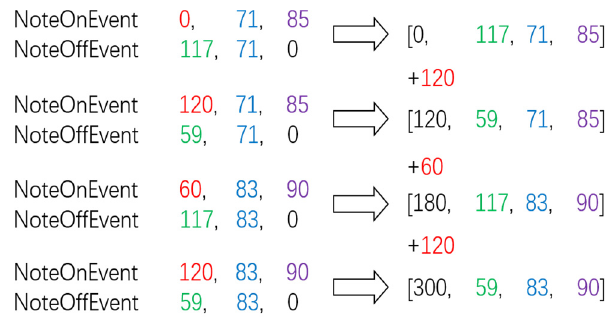
Figure 7. Preprocessed bar of melody track.